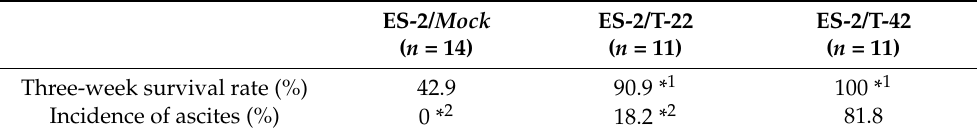
Figure 2. Patterns of dissemination of ES-2/mock cells and ES-2/T-42 cells in vivo. Nude mice were inoculated with ES-2/mock cells, ES-2/T-22 cells, or ES-2/T-42 cells. ( A ) Macroscopic and intraperitoneal findings of nude mice inoculated with ES-2/mock cells. Small red arrows indicate the position of tumors. ( B ) Macroscopic and intraperitoneal findings of nude mice inoculated with ES-2/T-42 cells. The big red arrow indicates a bloated abdomen due to accumulated ascites. ( C ) Tumor burden in mice intraperitoneally injected with ES-2/mock or ES-2/T-42 cells three weeks after cell inoculation. Mesentery, omentum, peritoneum, ovary, and uterus of the mice were resected together with implanted tumors, and their cumulative weights were measured. Each dot represents one mouse, and mean ± SEM are shown. Unpaired Student’s t -test. * p < 0.05. Table 1. Three-week survival rate and incidence of ascites in in vivo peritoneal dissemination model assay a .